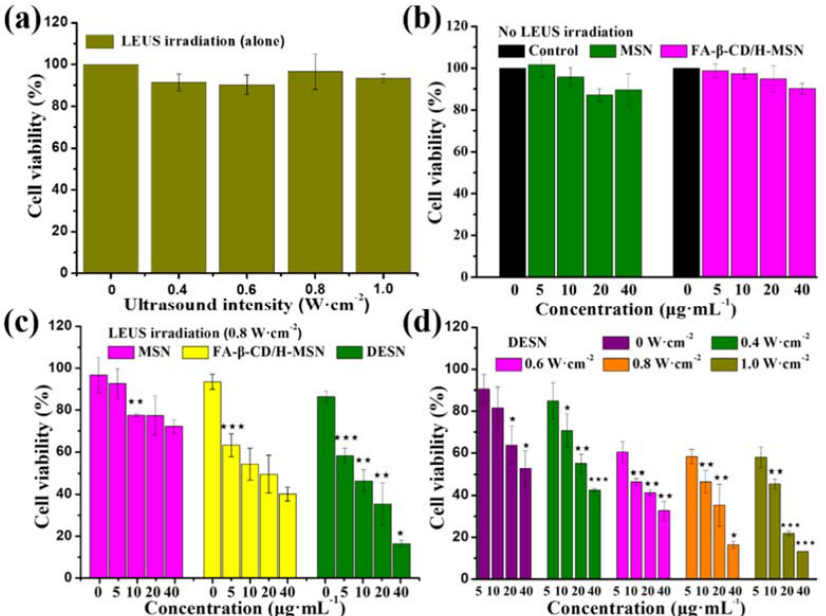
Figure 6. ( a ) Viability of 4T1 cells under low-energy ultrasound alone (1 MHz; 0, 0.4, 0.6, 0.8, and 1.0 W·cm − 2 ); ( b ) in vitro cytotoxicity of MSN and FA- β -CD/H-MSN against 4T1 cells after a 24-h co-culture. The concentration of MSN was equal to FA- β -CD/H-MSN. Compared with the control group, MSN and FA- β -CD/H-MSN exhibited almost no cytotoxicity; ( c ) The viability of 4T1 cells after being co-cultured with MSN, β -CD/H-MSN, and DESN at different concentration (0, 5, 10, 20, and 40 μ g·mL − 1 ) under 0.8 W·cm − 2 ultrasound irradiation and ( d ) Viability of 4T1 cells after co-culture with DESN with or without LEUS irradiation. FA- β -CD/H-MSN in synergistic combination with low-energy ultrasound ( ≤ 1.0 W·cm − 2 , 1 MHz) exerted enhanced toxicologic effects against tumor cells. DESN combined low-energy ultrasound with chemical therapy, making obvious the cell-killing effect. The results depicted were represented as means ± SDs ( n = 3). p < 0.05; p < 0.01; p < 0.001.